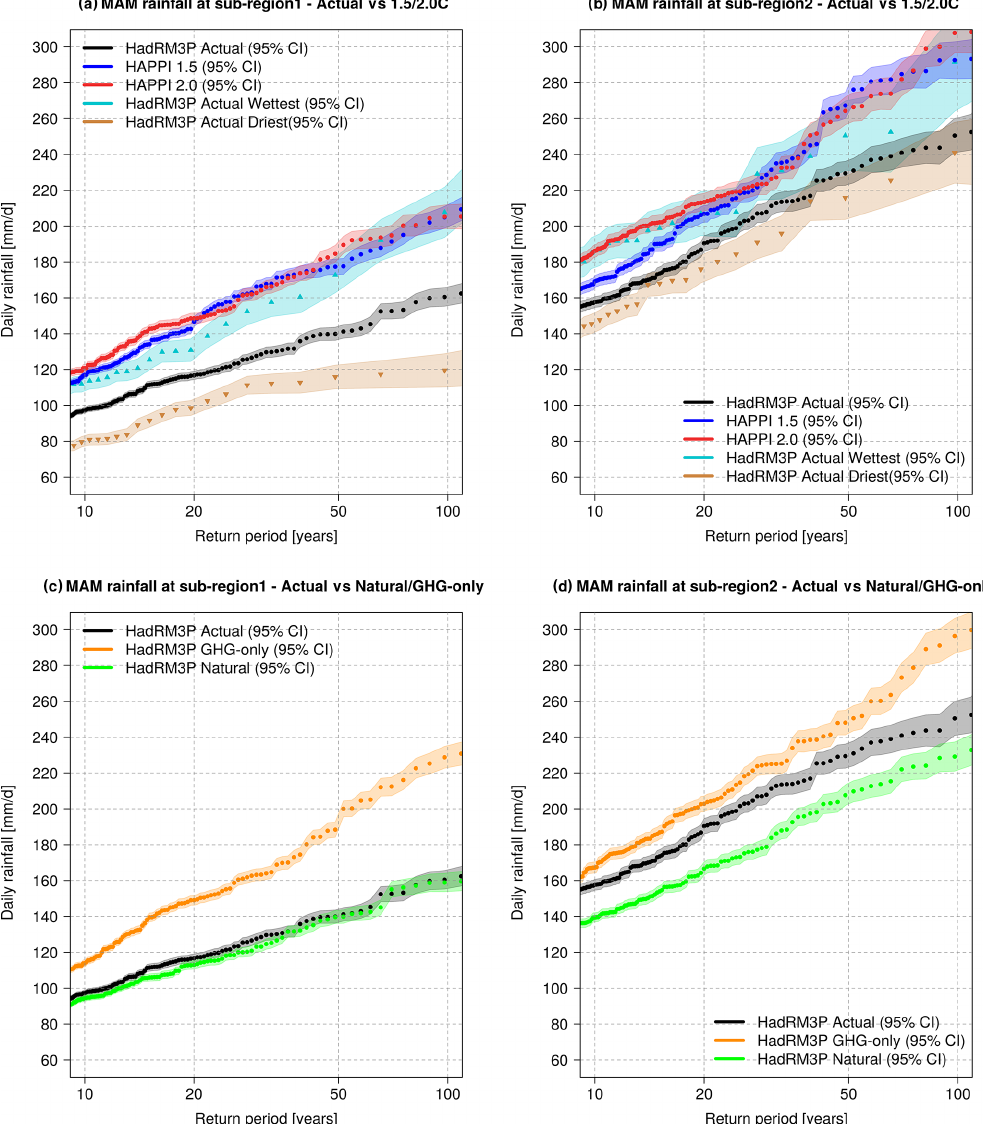
Figure 6. Return time plots for MAM daily rainfall under different forcing scenarios over the sub-regions 1 and 2 of Bangladesh. The ACT (black), ACT highest (sky-blue), ACT lowest (grey), NAT (green), and GHG-only (orange) ensembles are compared with the HAPPI 1.5 (blue) and HAPPI 2.0 (red)